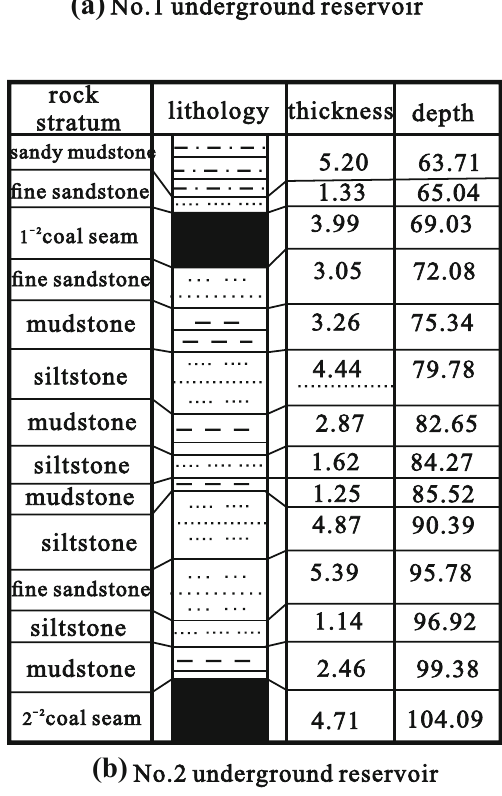
Fig. 3 Drilling log of No. 1 and No. 2 Underground Reservoir